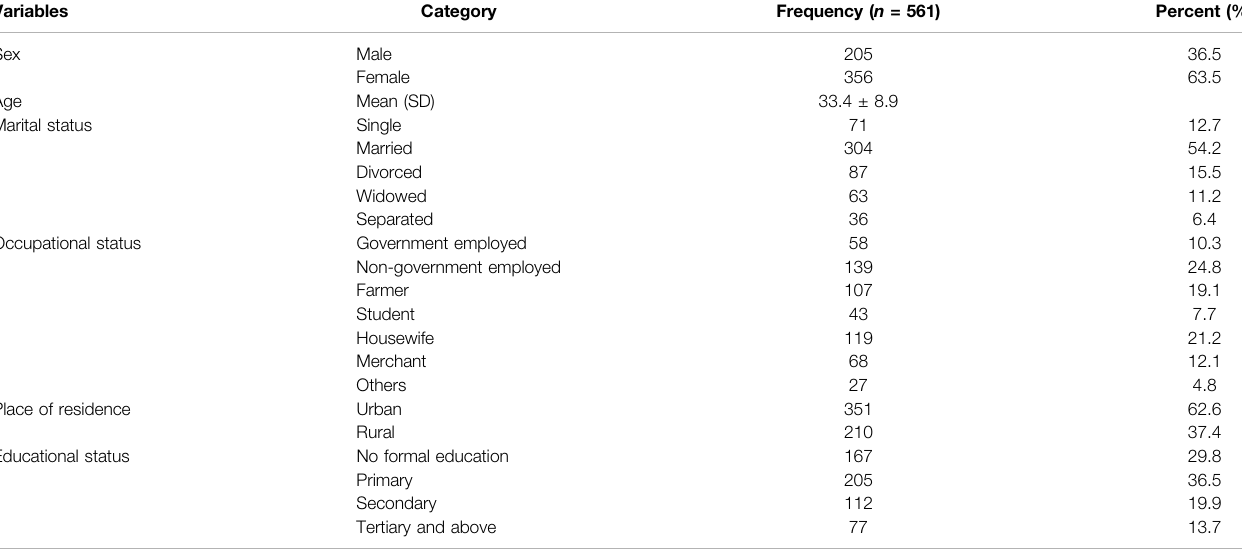
TABLE 1 | Baseline socio-demographic characteristics of HIV/AIDS patients on ART in Eastern Ethiopia, 2013 – 2019.